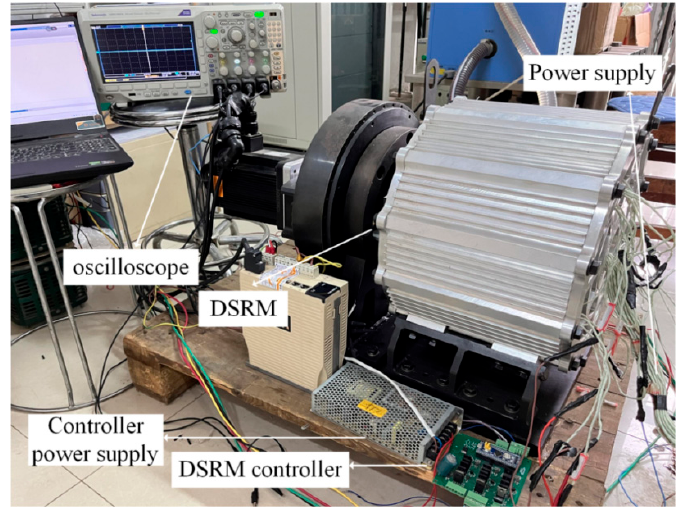
Figure 14. The experiment platform.